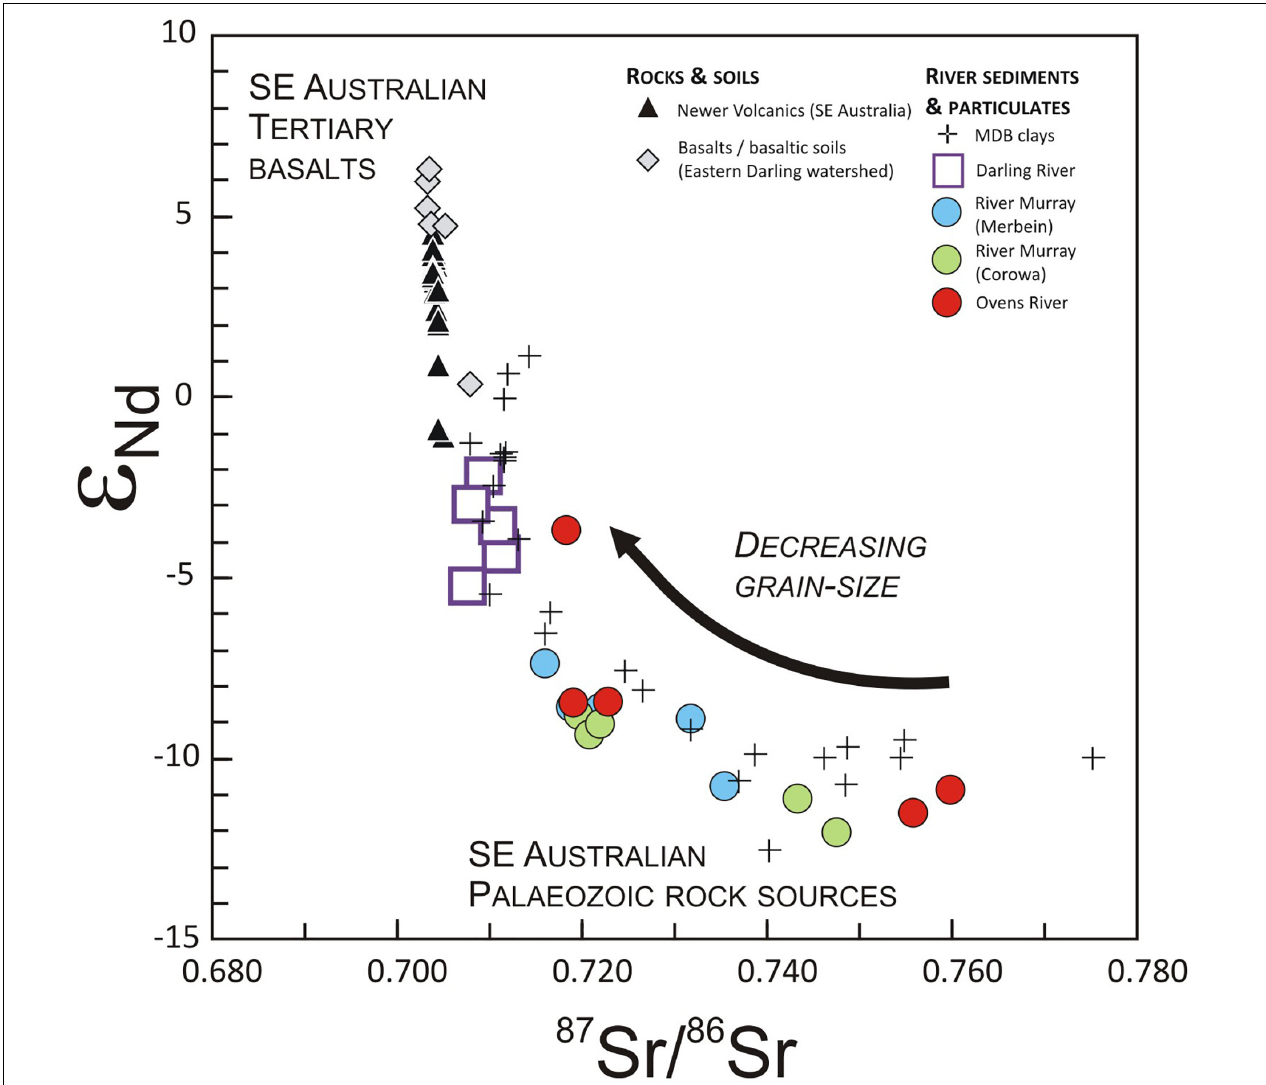
FIGURE 5 | 143 Nd/ 144 Nd (expressed as ε Nd ) versus 87 Sr/ 86 Sr variation for the grain-size fractions separated from river suspended matter in the Murray-Darling Basin (MDB). Also shown for comparison are renormalized Sr-Nd data for various basaltic rocks and soils (McDonough et al., 1985; Martin and McCulloch, 1999) and clay-size fractions from the MDB (Gingele and De Deckker, 2005b). All grain-size fractions plot on the general mixing trend defined by SE Australian Tertiary basalts and Palaeozoic granitoids and metasedimentary rocks, suggesting that the finest size-fractions in river suspended particulates incorporate higher contribution of volcanogenic